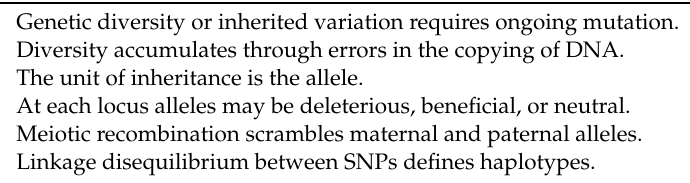
Table 2. Alternative dogma.